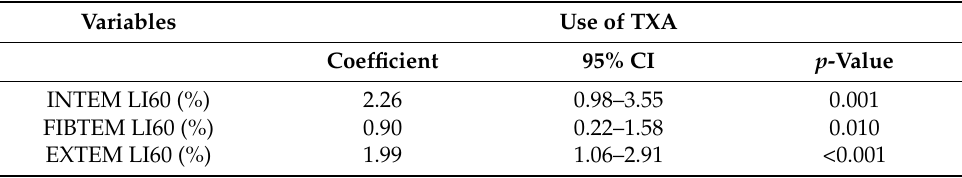
Table 6. Results of a multivariable regression analysis for the evaluation of the effect of TXA on the ROTEM parameters adjusted for age, gender, BMI, resection length and type of resection (proximal femur, distal femur, proximal